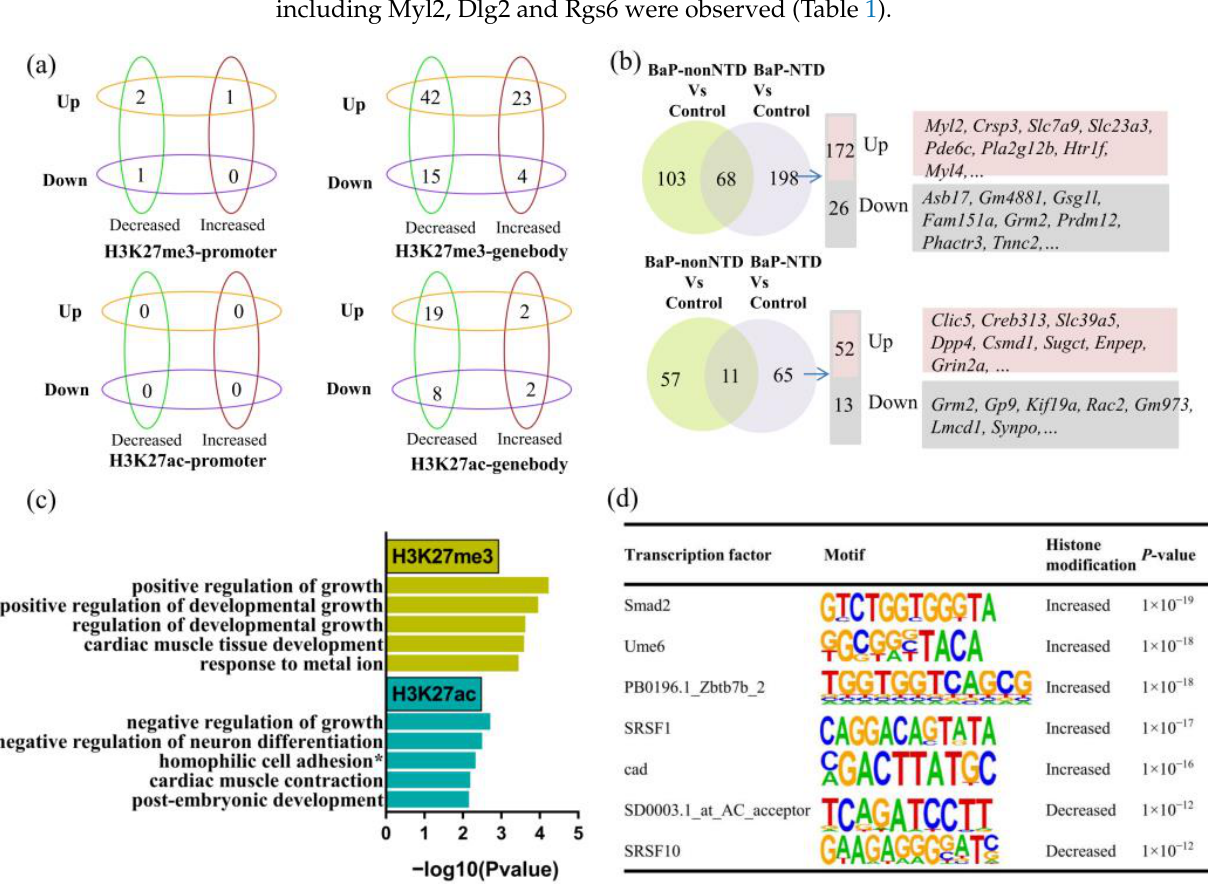
Table 1. The differentially expressed genes with histone modifications unique for E9.5 BaP-NTD embryos.